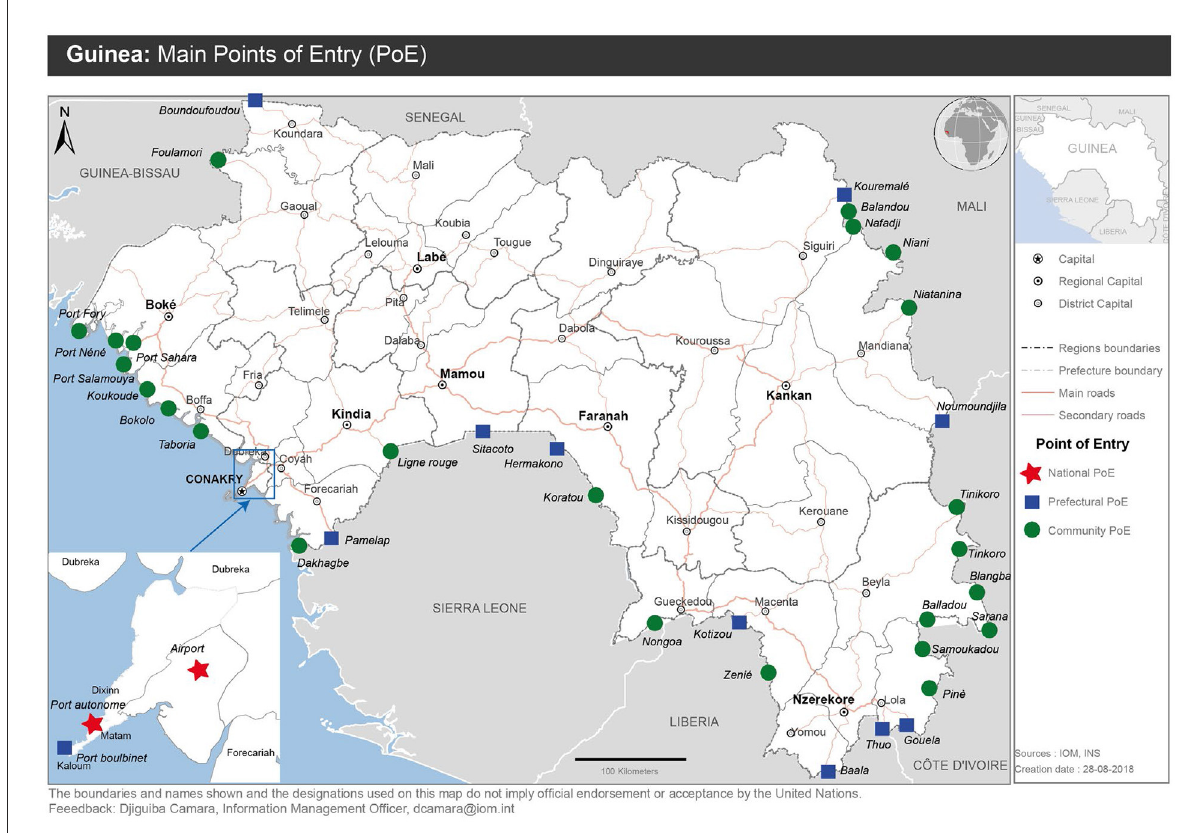
FIGURE2 Points of entry targeted for surveillance strengthening,